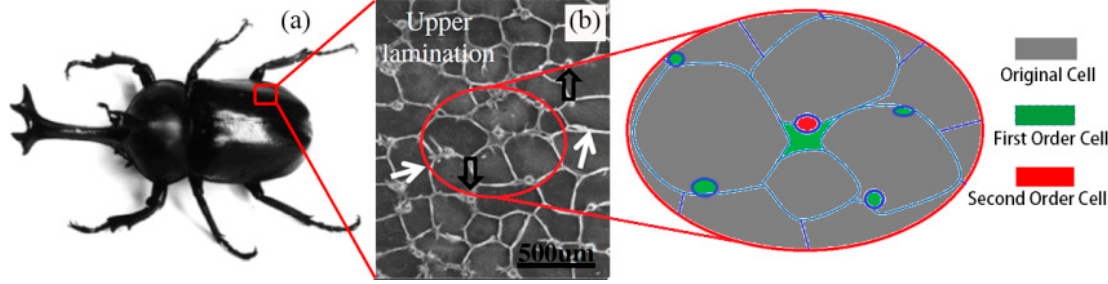
Figure 1. The beetle elytra and its microstructure: ( a ) the beetle Allomyrina dichotoma ; ( b ) micromorphology of honeycomb structure with columns. “Reproduced with permission from [CARBOHYD POLYM]. Elsevier, 2013.”.